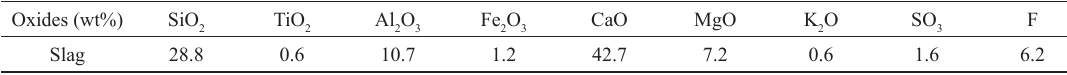
Table 3. Chemical composition of the selected synthetic slag.